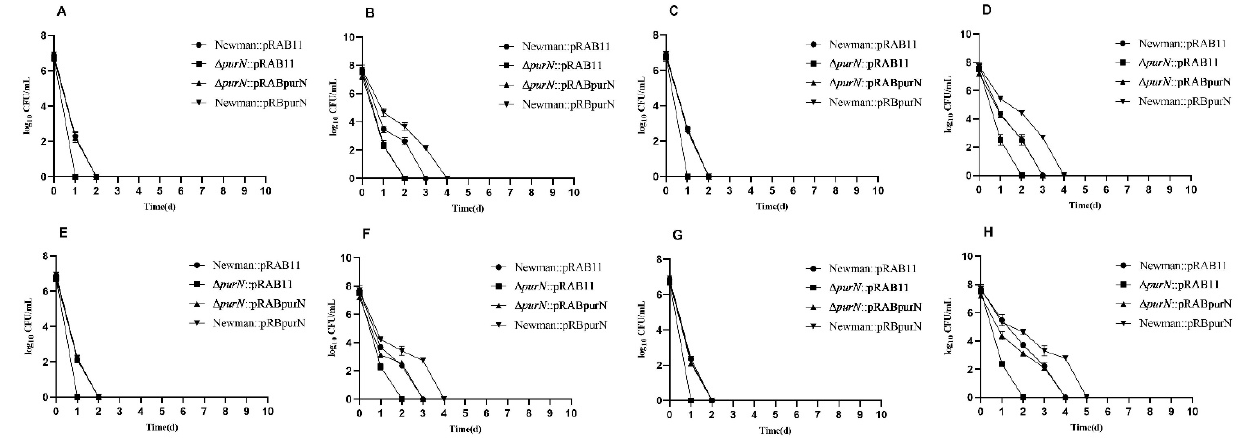
Figure 2. Drug exposure results of Newman::pRAB11, ∆ purN ::pRAB11, ∆ purN ::pRABpurN, and Newman::pRBpurN to ampicillin ( A , B ), vancomycin ( C , D ), gentamicin ( E , F ) and levofloxacin ( G , H ) at different culture times. 5-h culture ( A , C , E , G ); 9-h culture ( B , D , F , H ).